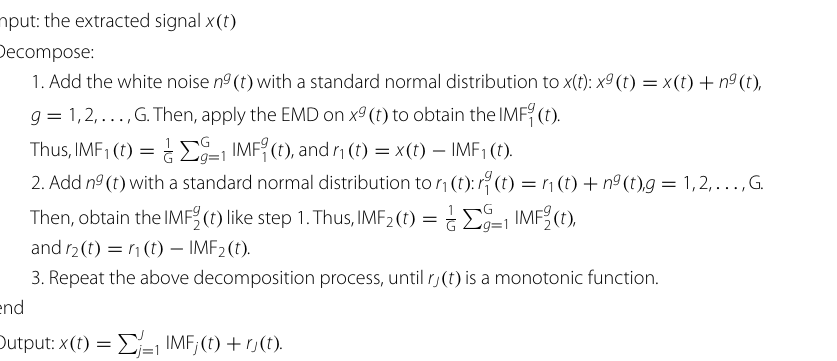
Table 1 IMFs extraction with CEEMDAN